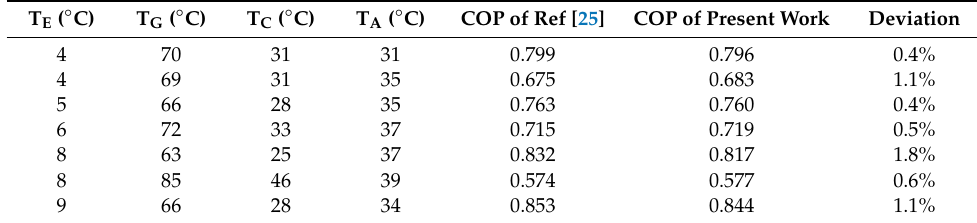
Table 2. Model validation for absorption heat pump.